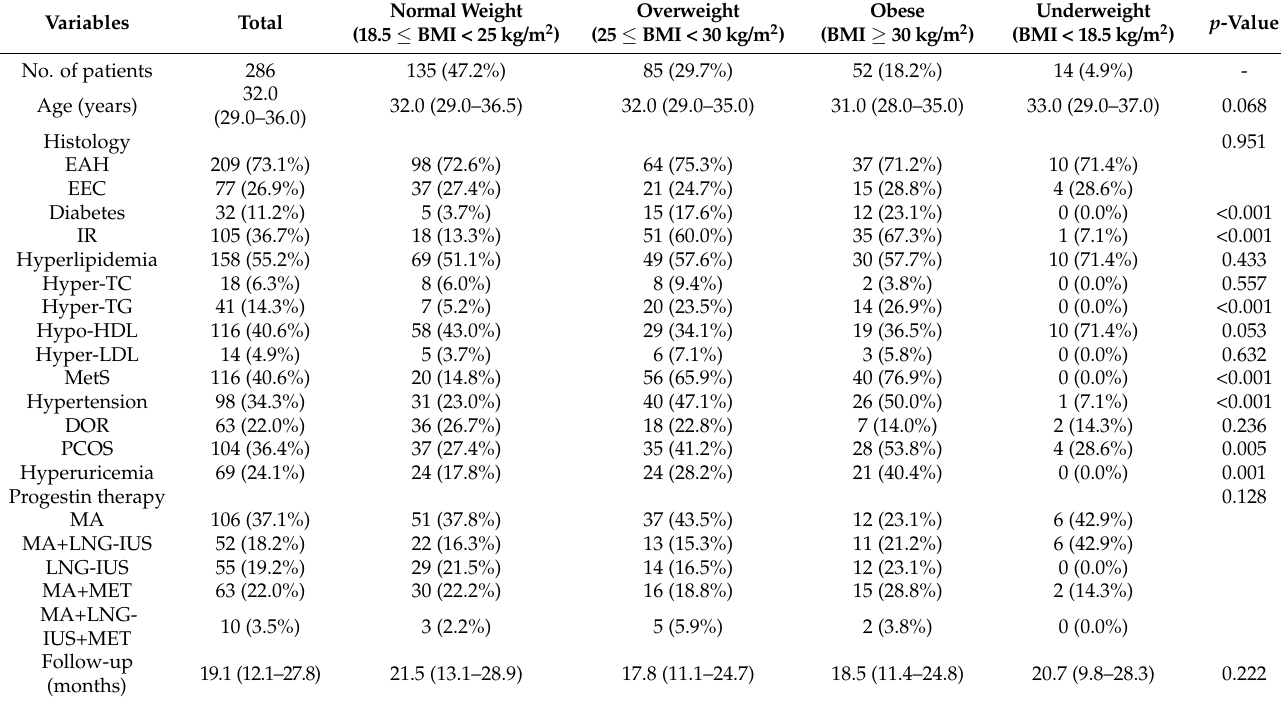
Table 1. Baseline and metabolic characteristics across weight